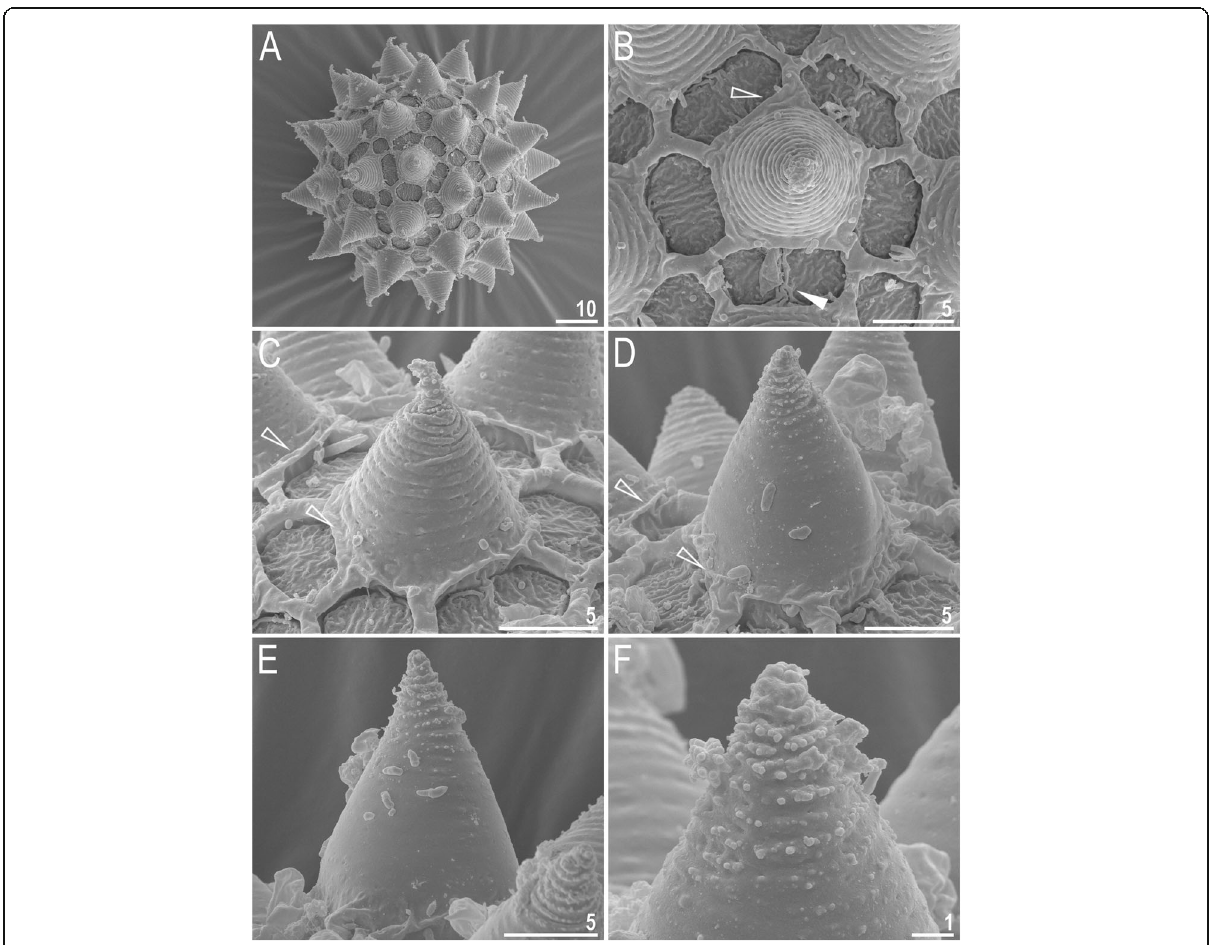
Fig. 10 Macrobiotus pallarii Maucci, 1954 from the topotypic population (IT.337) – eggs seen with SEM: a – entire view of the egg; b – f – details of the egg surface between processes, areolation and egg processes. Filled flat arrowheads indicate thickening perpendicular to the process base that divides the areola in the middle, empty flat arrowheads indicate irregular collar around process bases. Scale bars in μ